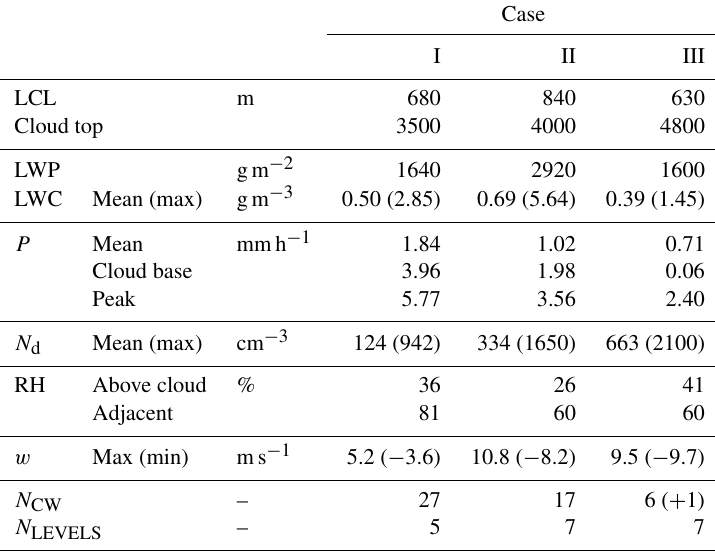
Table 1. Cloud system and environmental summary